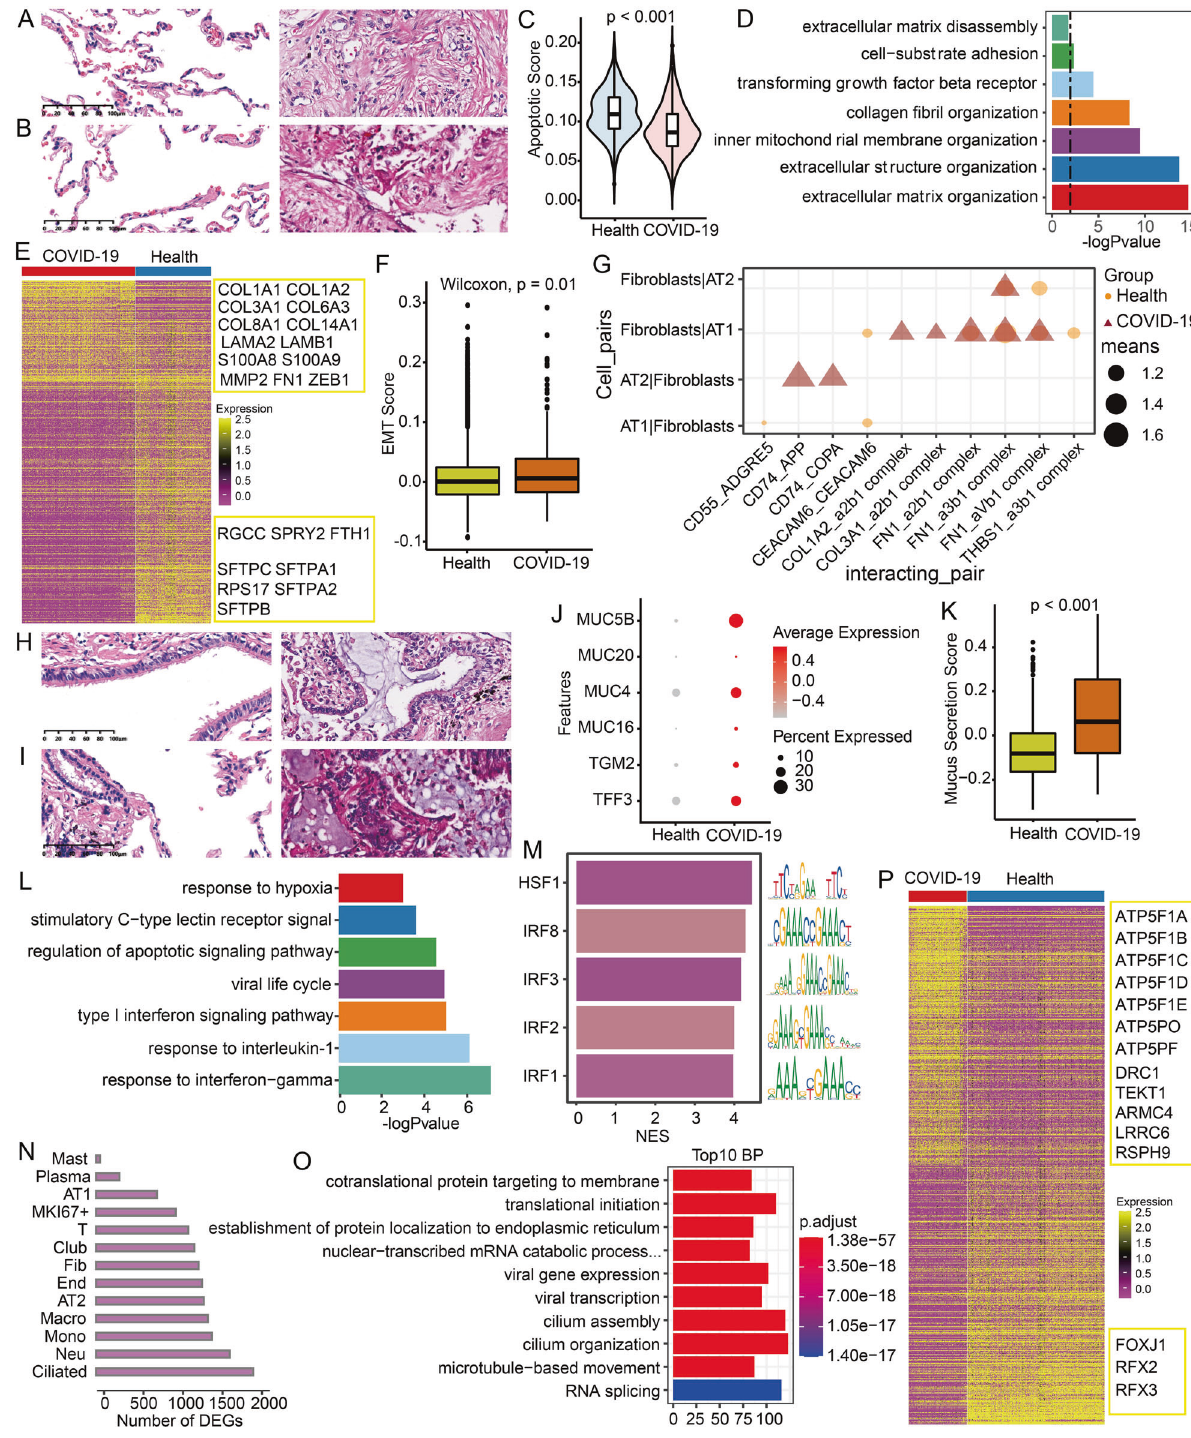
Fig. 4 Increased fi brosis and mucus accumulation in lung in fl ammatory environment. A , B HE staining showed increased pulmonary fi brosis in COVID-19 group compared with control group. On the left are two controls (C1, C2) and on the right are two dead patients (P1, P2). C The difference in apoptosis scores of fi broblasts between healthy and COVID-19 groups. D Differentially expressed genes (DEGs) of fi broblasts are enriched in the biological processes related to fi brosis. E Expression changes of fi brosis-related genes in healthy and COVID-19 groups. F The difference in EMT scores between healthy and COVID-19 groups. G Signi fi cantly changed ligand and receptor during the communication between AT1/AT2 cells and fi broblasts. H , I HE staining showed increased mucus accumulation in COVID-19 compared with control. J Expression changes of genes related to mucus formation and mucus consistency in healthy and COVID-19 groups. K The difference in EMT scores between healthy and COVID-19 groups. L The DEGs of club cells are enriched in biological processes related to antiviral and in fl ammation. M Top transcription factor enriched from DEGs in club cells. N The number of DEGs in different cells of the lung. O The top 10 enriched biological process of DEGs in ciliated cells. P Expression changes of genes related to cilia function in healthy groups and COVID-19